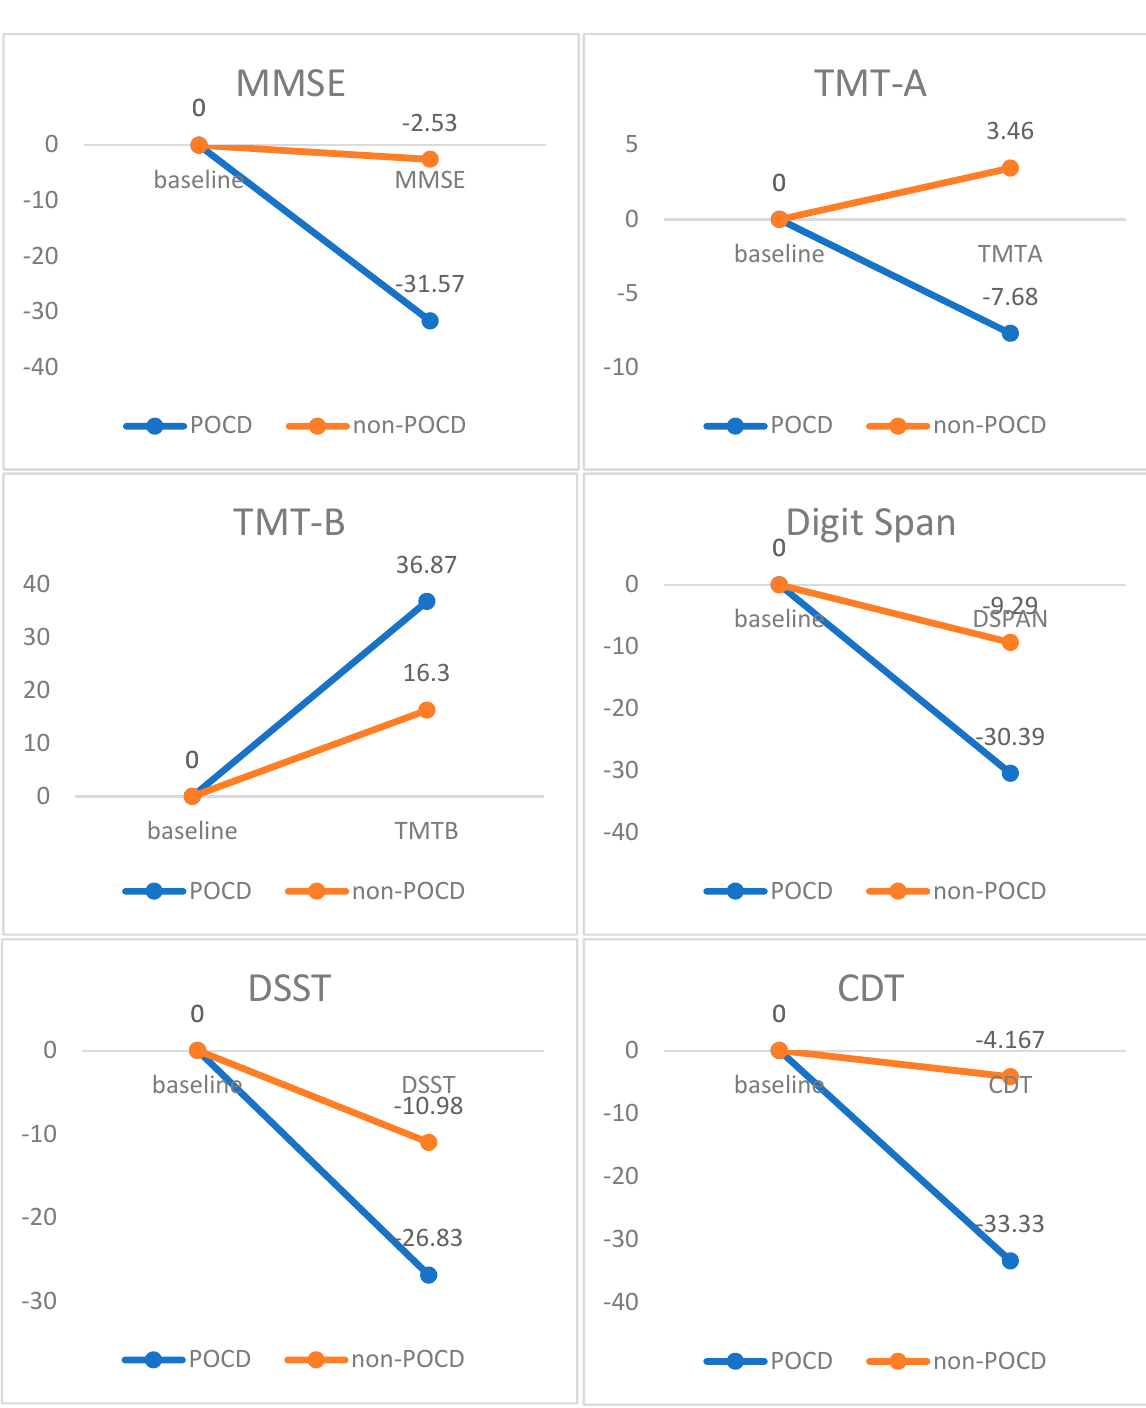
Figure 1. Percentage differences between POCD and non − POCD patients in all tests. MMSE = Mini − Mental State Examination; TMT = Trail Making Test; DSST = digit symbol substitution test; CDT = clock drawing test.